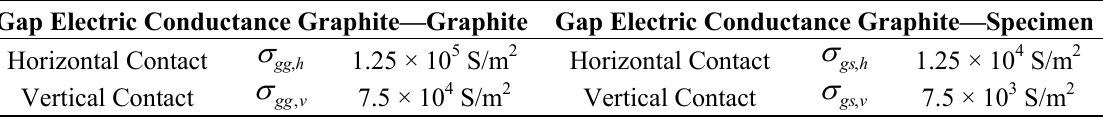
Table 4. Parameters used for Gap Electric Conductivity in the Contact between Parts . Gap Electric Conductance